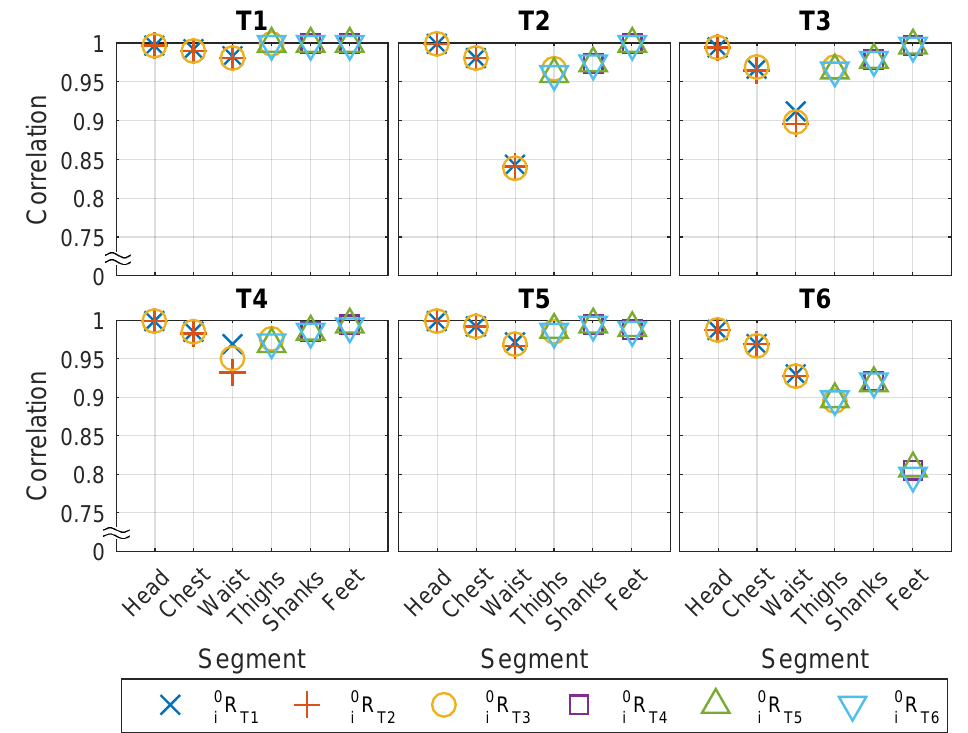
Acceleration correlation between sensors on different sides of the same segment, with different T ex